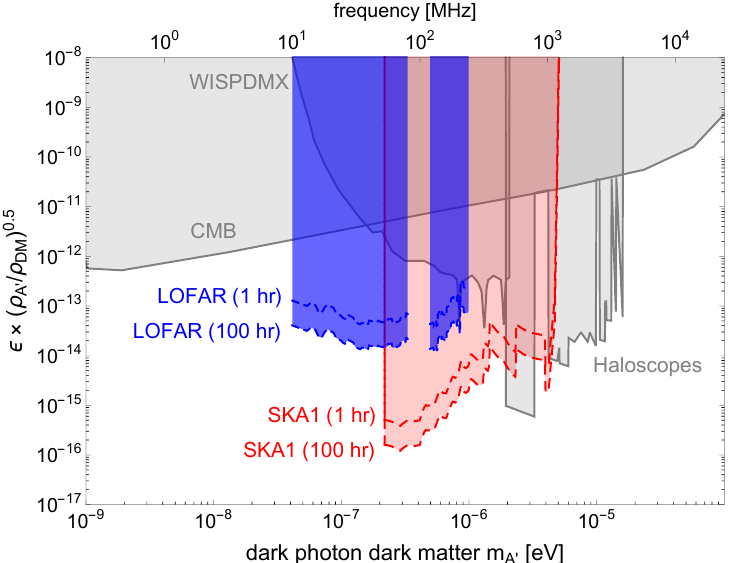
Figure 2. The projected sensitivity of the parameter space of the dark photon dark matter based on the radio telescopes SKA phase 1 and LOFAR, with the observation time assumed to be 1 and 100 h, respectively. The plot also shows the existing constraints from CMB [8,86], the cavity experiment WISPDMX [87], and the multiple haloscope-type experiments [8,100–104]. Figure adapted from [67].